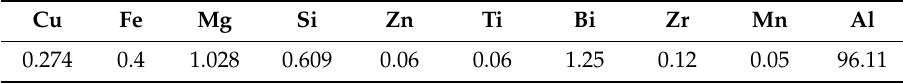
Table 1. Nominal chemical compositions of 6065 aluminum alloy (wt %).